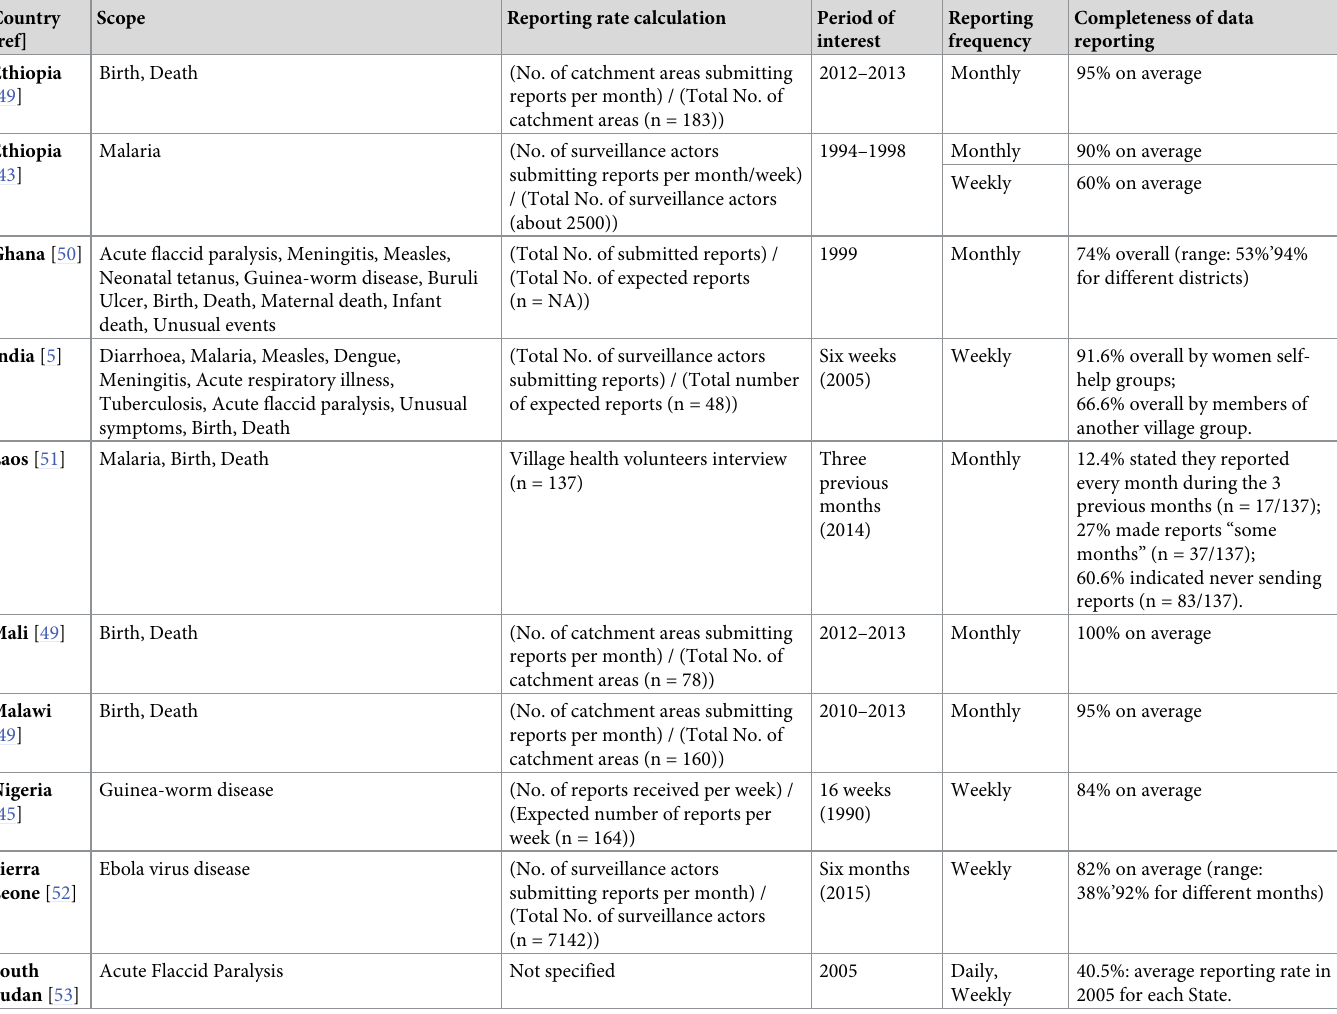
Table 4. Completeness of data reporting for CBS